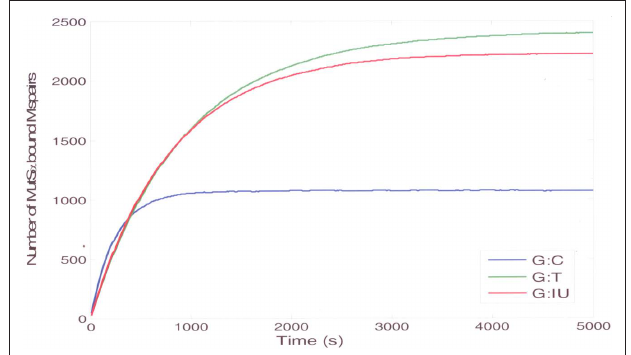
Figure 6 | The stochastic simulation results (mean curves) for the binding of MutSa to substrates that contain g:C (blue curve), g:T (green curve), or g:iu (red